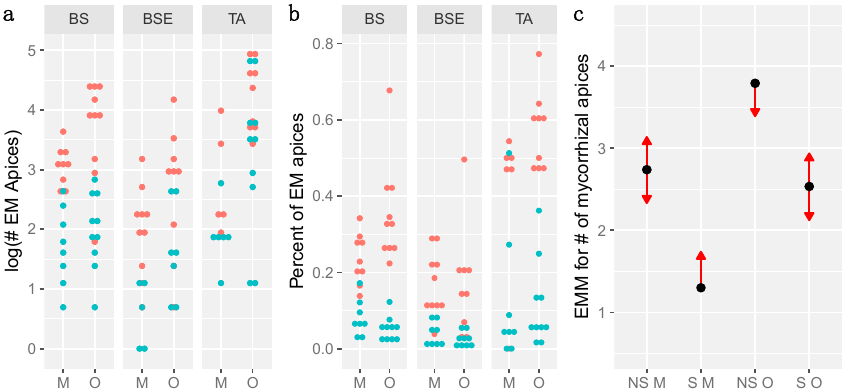
Figure 3. Number (#) of ectomycorrhizal (EM) apices ( a , log transformed), Percent of ectomycorrhizal apices ( b ) and comparison of estimated marginal means (EMM, c ) between stands, layers and sterilization treatments. BS: Black spruce stand, BSE: BS with Ericaceae, TA: Trembling Aspen stand, NS: non sterile, S: sterile, M: Mineral, O: Organic. In ( a , b ), blue dots refer to sterile treatments, and red dots to non-sterile treatments. In ( c ), blue bars indicate confidence intervals of estimated marginal means, arrows refer to comparisons among marginal means. If two arrows overlap, Tukey post-hoc tests are non-significant and p -value for pairwise comparisons are > 0.05. Table 1. General linear mixed effect models (GLMM) and linear mixed effect models (LMM) estimates for the number (#) and percent (%) of ectomycorrhizal (EM) apices. Std: standard error, p: p -value. *: p -value < 0.01, **: p -value < 0.001, ***: p -value < 0.0001. Model formula: ~Layer + Layer/Steril + (1|Stand/Treatment).